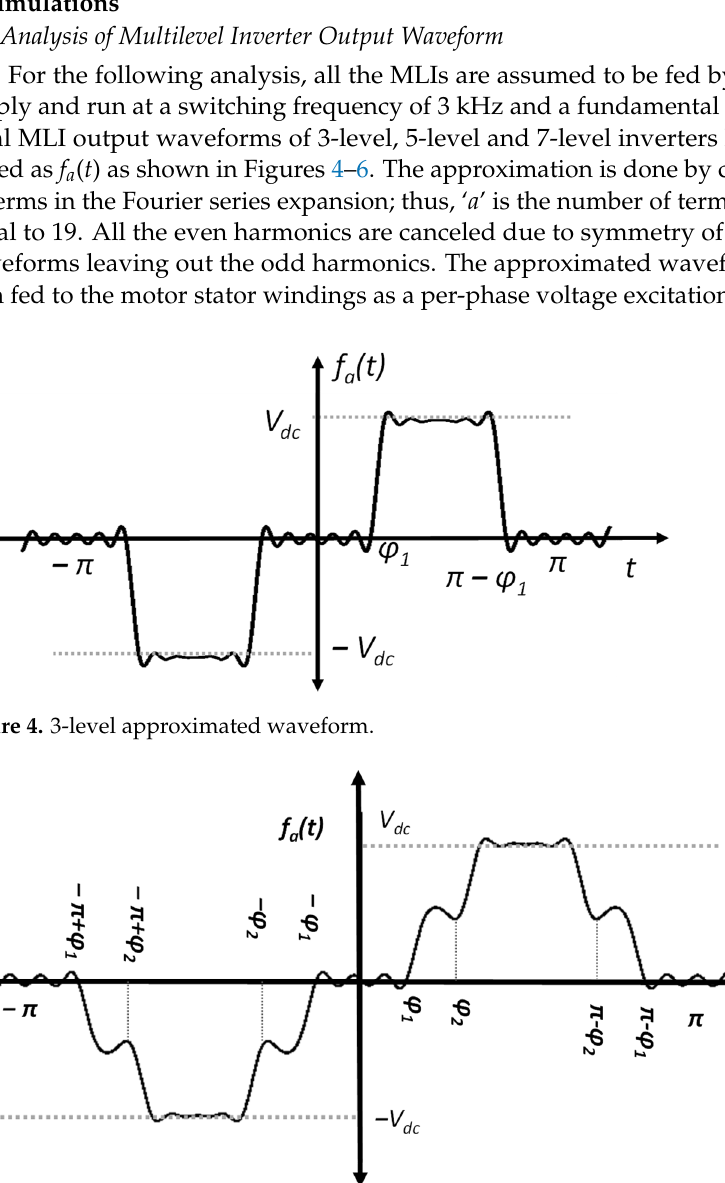
Figure 6. The mathematical representation of a 7-level inverter output voltage is given in Equation (6).